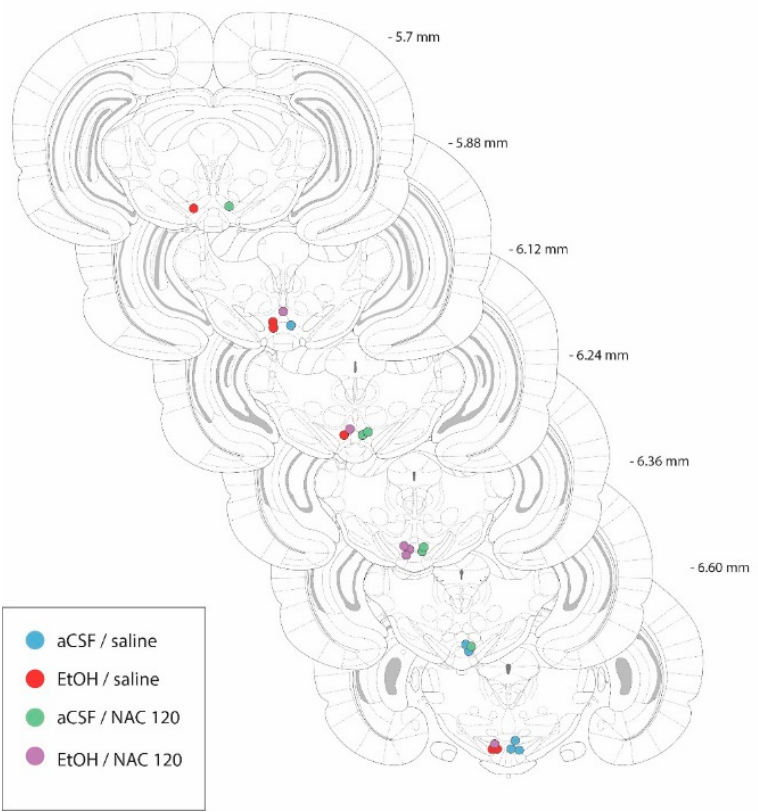
Figure 3. Diagram of coronal sections from the brains of rats used in experiment 2, indicating the placement of the tip of the injection cannulae in the posterior VTA. In order to facilitate the inspection of the figure, the placements from animals belonging to the aCSF-treated groups are shown on the right-hand side of the sections, whereas the placements from the EtOH-treated animals are shown on the left-hand side. Numbers indicate the distance from the anterior coordinate to the bregma. Adapted from Paxinos and Watson [26].